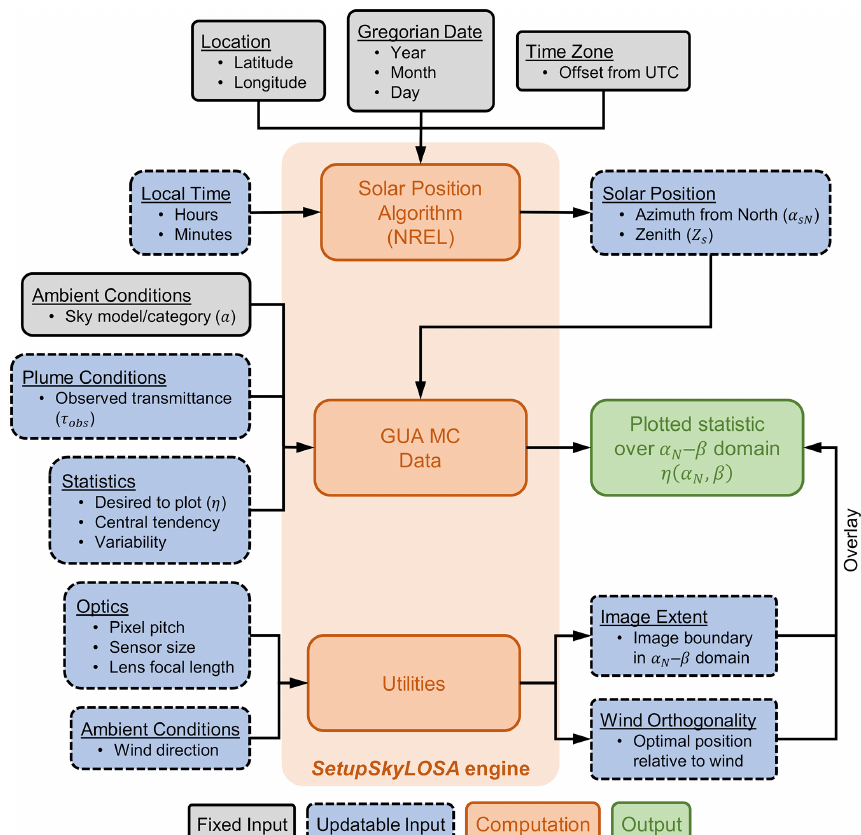
Figure 6. Flow chart of the main procedure of the SetupSkyLOSA software tool. The user provides the location, Gregorian date, time zone, and local time, which are used to compute the corresponding solar position using the Solar Position Algorithm of the National Renewable Energy Laboratory (NREL; Reda and Andreas, 2008). Then, with data on ambient conditions and observed plume transmittance, the software tool plots the desired statistic of soot mass column density over the α N − β domain. Additional utilities include the overlay of the image sensor and optimal positioning relative to the wind on the plotted statistic, in addition to the “maximizer” and “positioner” utilities, which are not shown in the figure. The latter two utilities permit a user to identify acceptable camera positions and pointings over a measurement period and output these data in .kml format for use with mapping software such as Google Earth.